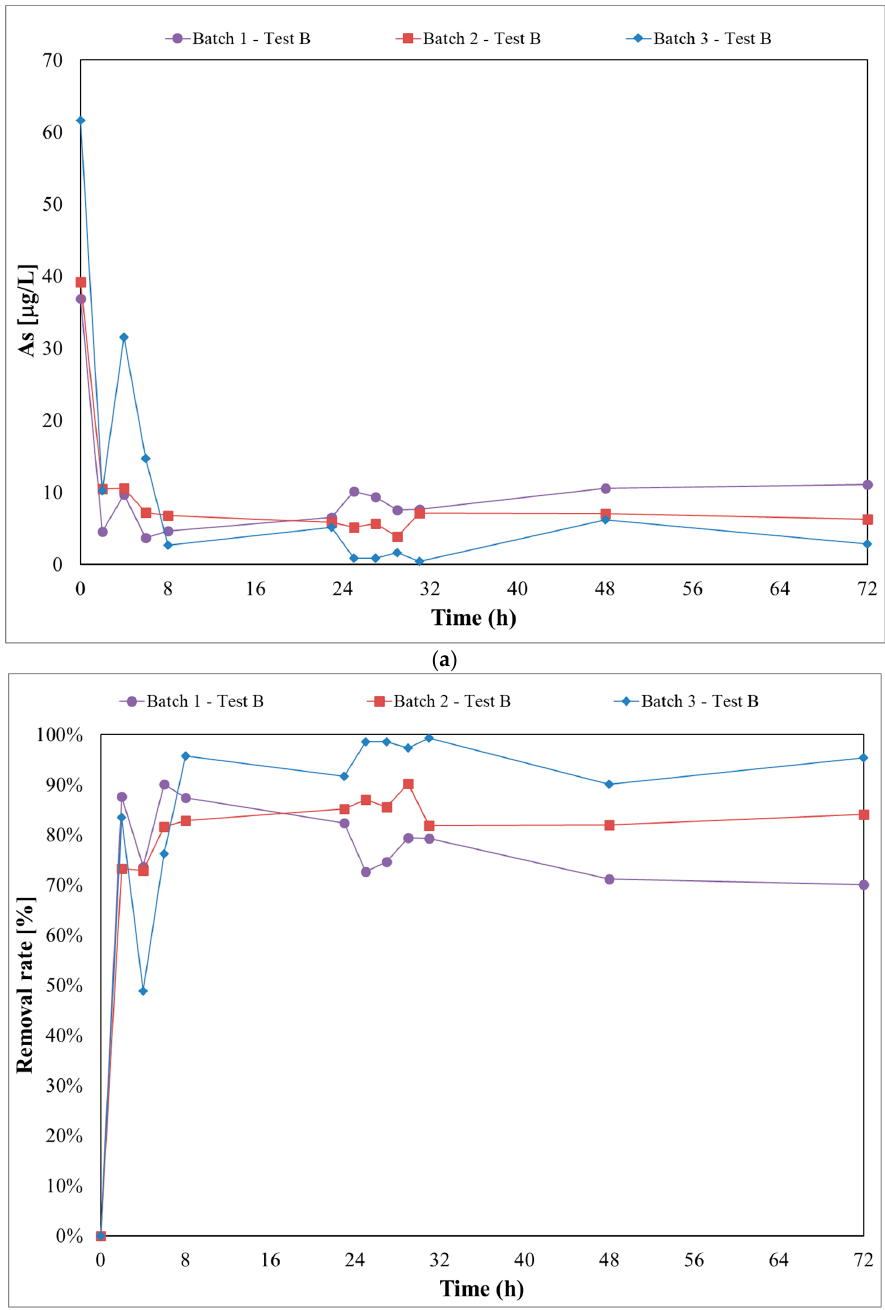
Figure 7. Experimental results for Test B. ( a ) As concentrations trend; ( b ) As removal rate .